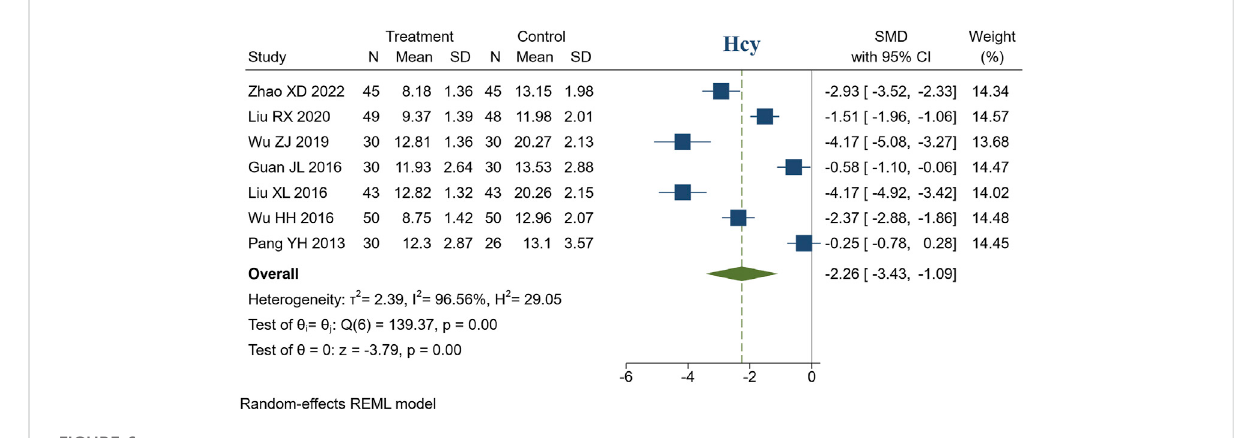
FIGURE 6 Forest plot of Hcy.